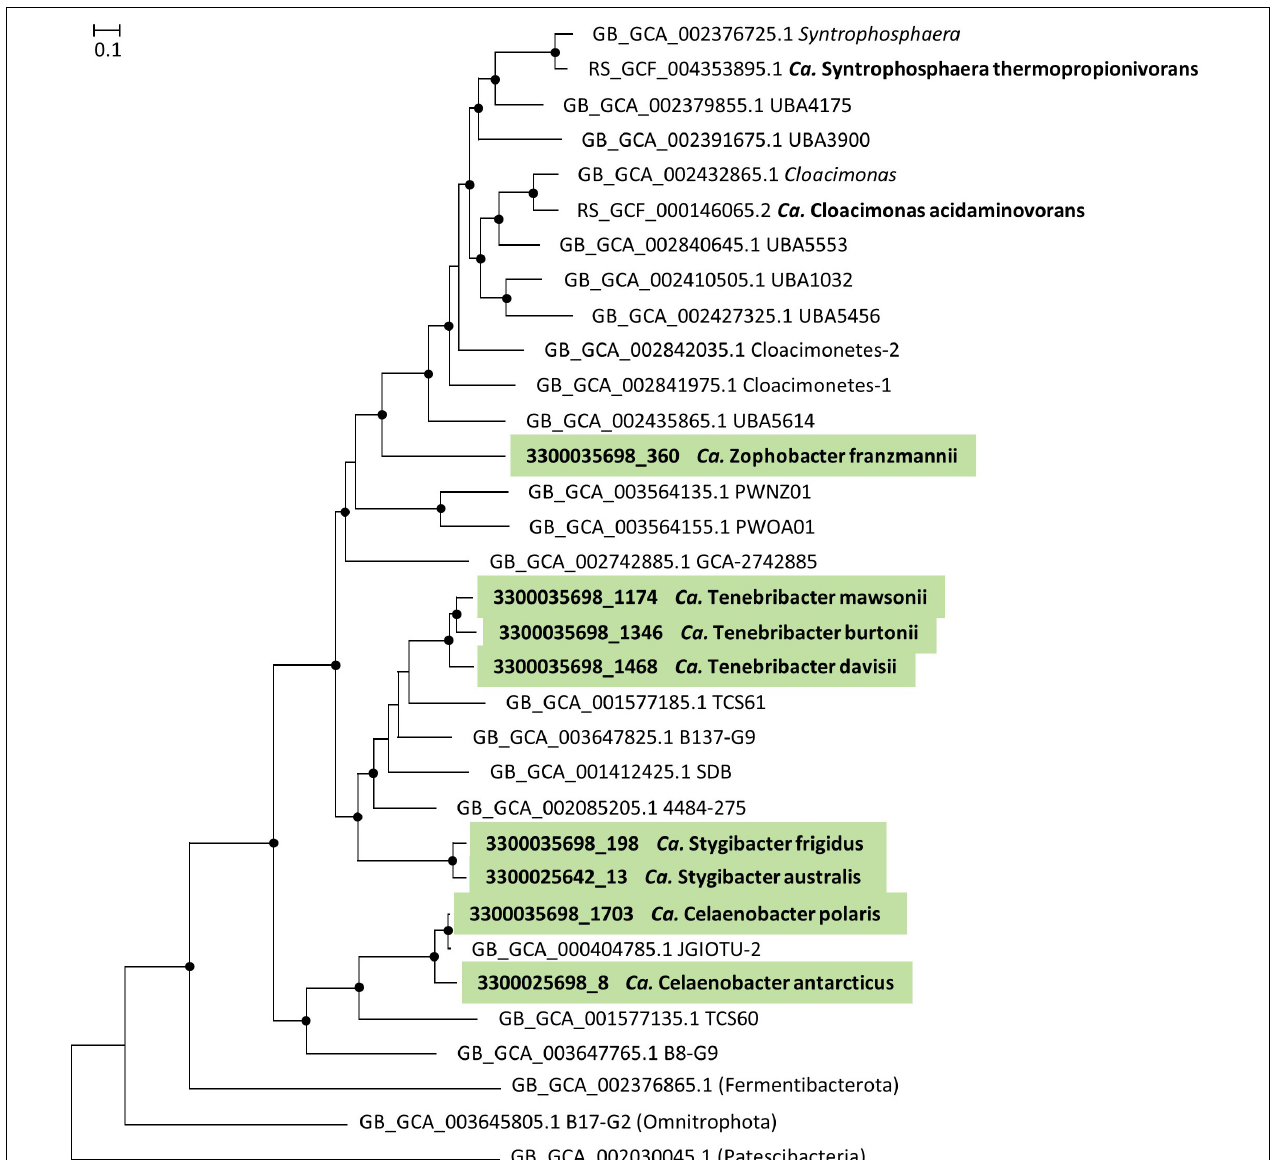
FIGURE 1 | Phylogeny of phylum Candidatus Cloacimonadota. Maximum likelihood tree constructed in IQ-Tree with autoselection of the best-fit model (LG + F + I + G4) and 1,000 ultra-fast bootstraps. UFBootstraps ≥ 95% (black dot); Metagenome-assembled genomes (MAGs) featured in this study (green) with their IMG MAG ID and proposed Candidatus genus and species name. Reference Cloacimonadota MAGs are shown with their Genome Taxonomy Database (GTDB) accession and GTDB taxonomy, except for Candidatus Cloacimonas acidaminovorans and Candidatus Syntrophosphaera thermopropionivorans,